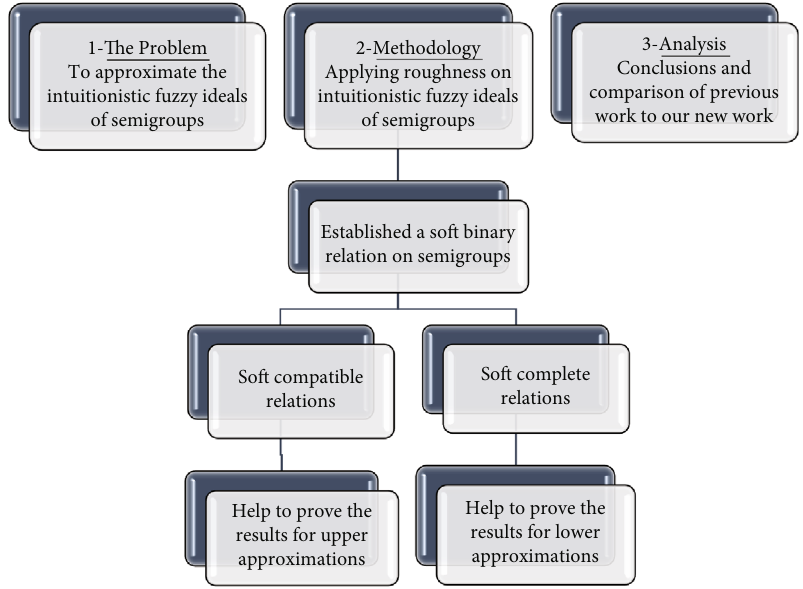
Figure 1: Flow chart of proposed